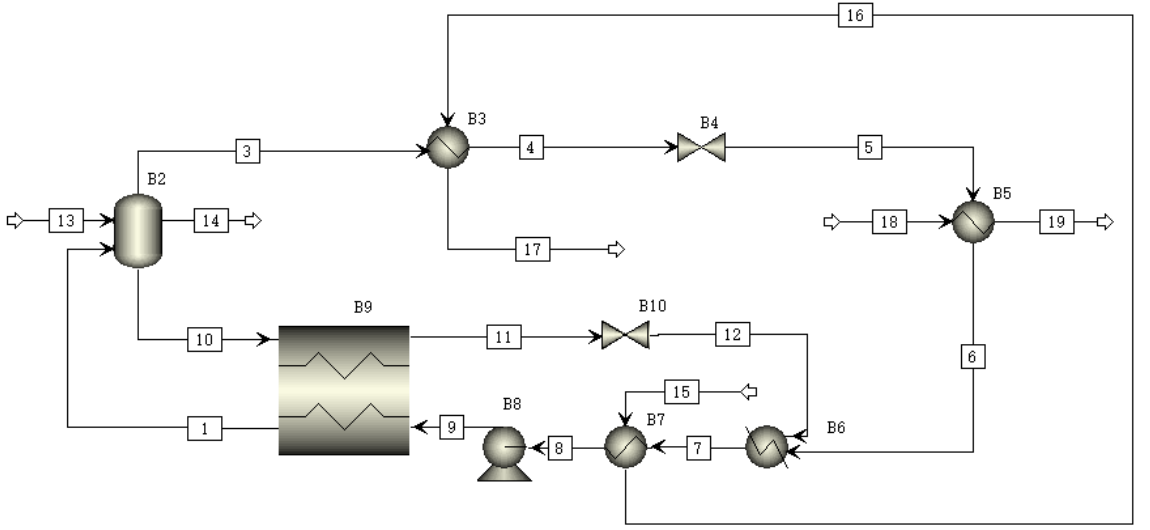
Figure 1. The cycle model implemented in Aspen Plus. Table 1. Description of the main symbols used in the models. Module Symbol